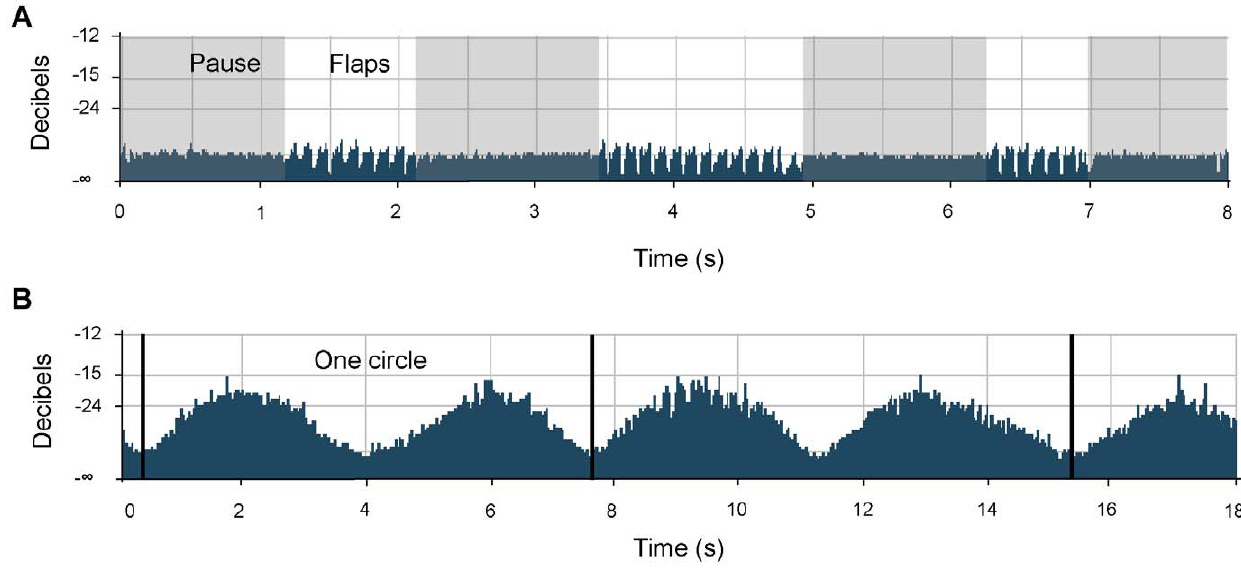
Figure 2. Received audio signals characterizing different flight modes of migratory European bee-eaters during flight. Each activity is characterized by a unique, identifiable signature of the audio power magnitude (decibels) in relation to the baseline power. (A) Flapping flight is characterized by two alternating phases; the first consists of a series of wing beats that are indicated by thick spikes, followed by a pause (grey shaded) of similar duration. (B) Soaring flight is characterized by sinusoidal signal strength due to null reception when the antenna of the tag is facing 180 u and 360 u towards the receiving antenna while the birds rise in the air in circular path. Thick vertical lines separate between different circles.